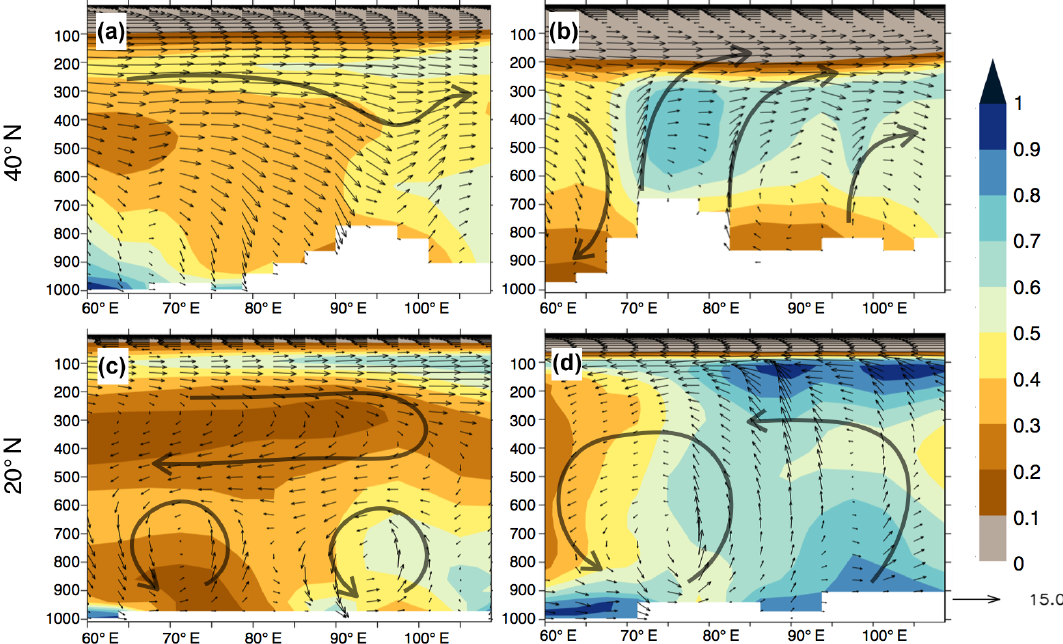
Figure 7. Longitude–altitude profiles of the relative humidity (shaded) and vertical winds (vectors) for the (a, c) EOC4X and (b, d) control simulation, at (a, b) 40 ◦ N and (c, d) 20 ◦ N. Values are taken from the month of July.